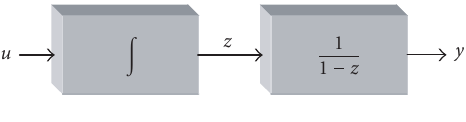
Figure 4.1. A simple Wiener